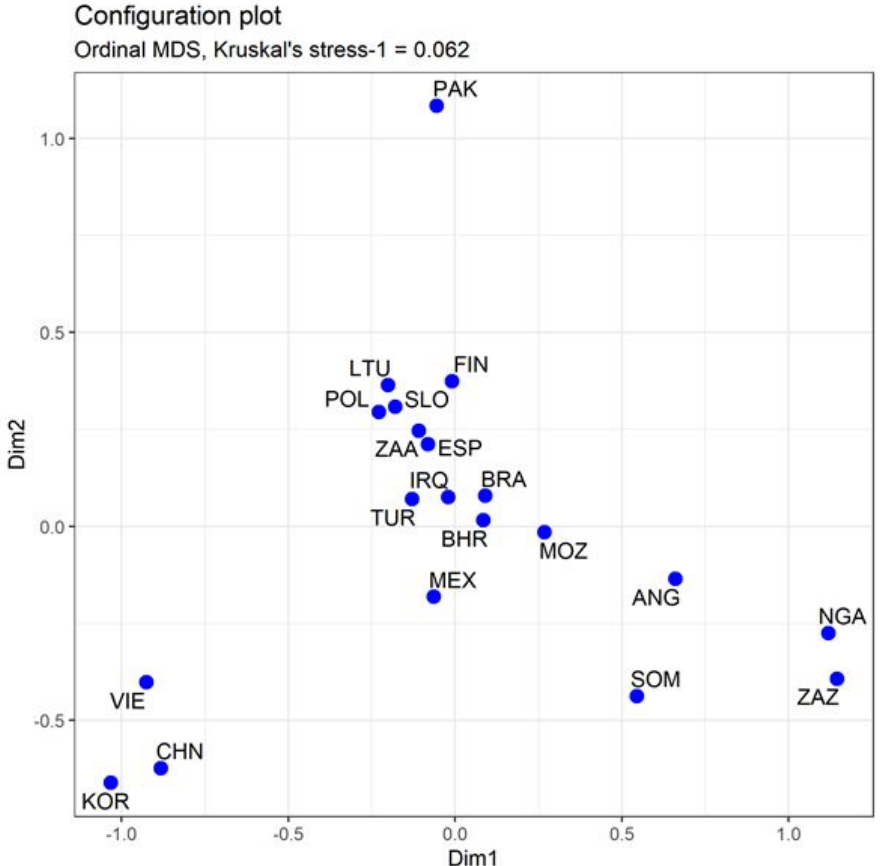
Figure 2. Multi-dimensional scale (MDS) plot of the Polish population and 19 other reference populations based on FST distances.